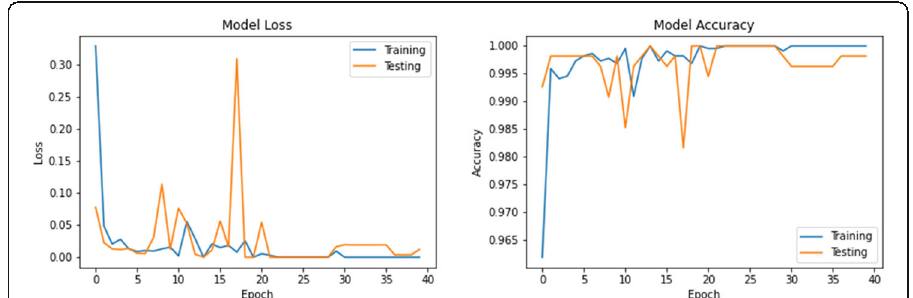
Fig. 10 DenseNet121 accuracy loss